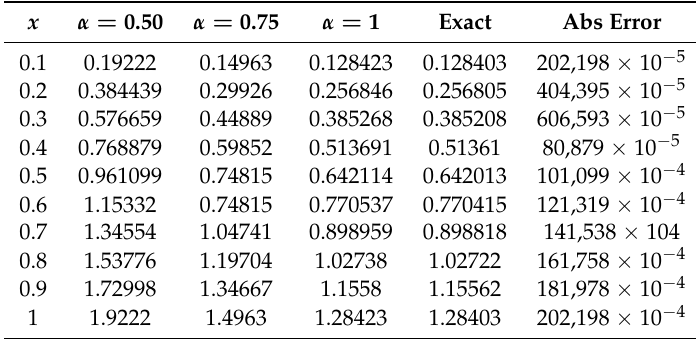
Table 12. Third order approximate results for different values of α at t = 0.25 of Example 3.